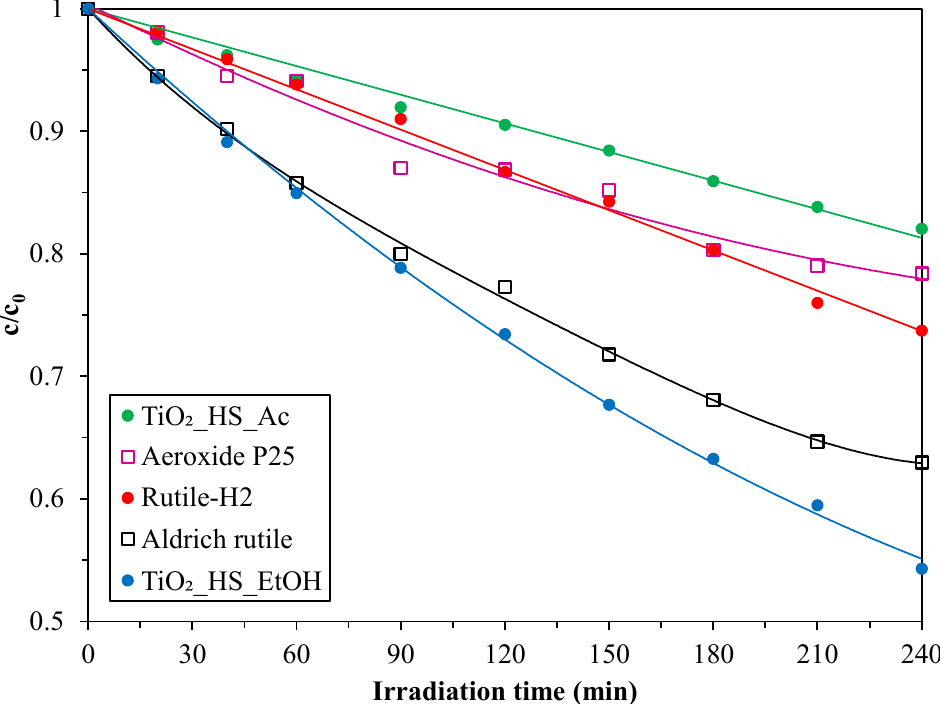
Figure 3. Photocatalytic degradation of the phenol model pollutant under visible light irradiation (c phenol = 0.1 mM, c TiO2 = 1 g · L − 1 ).